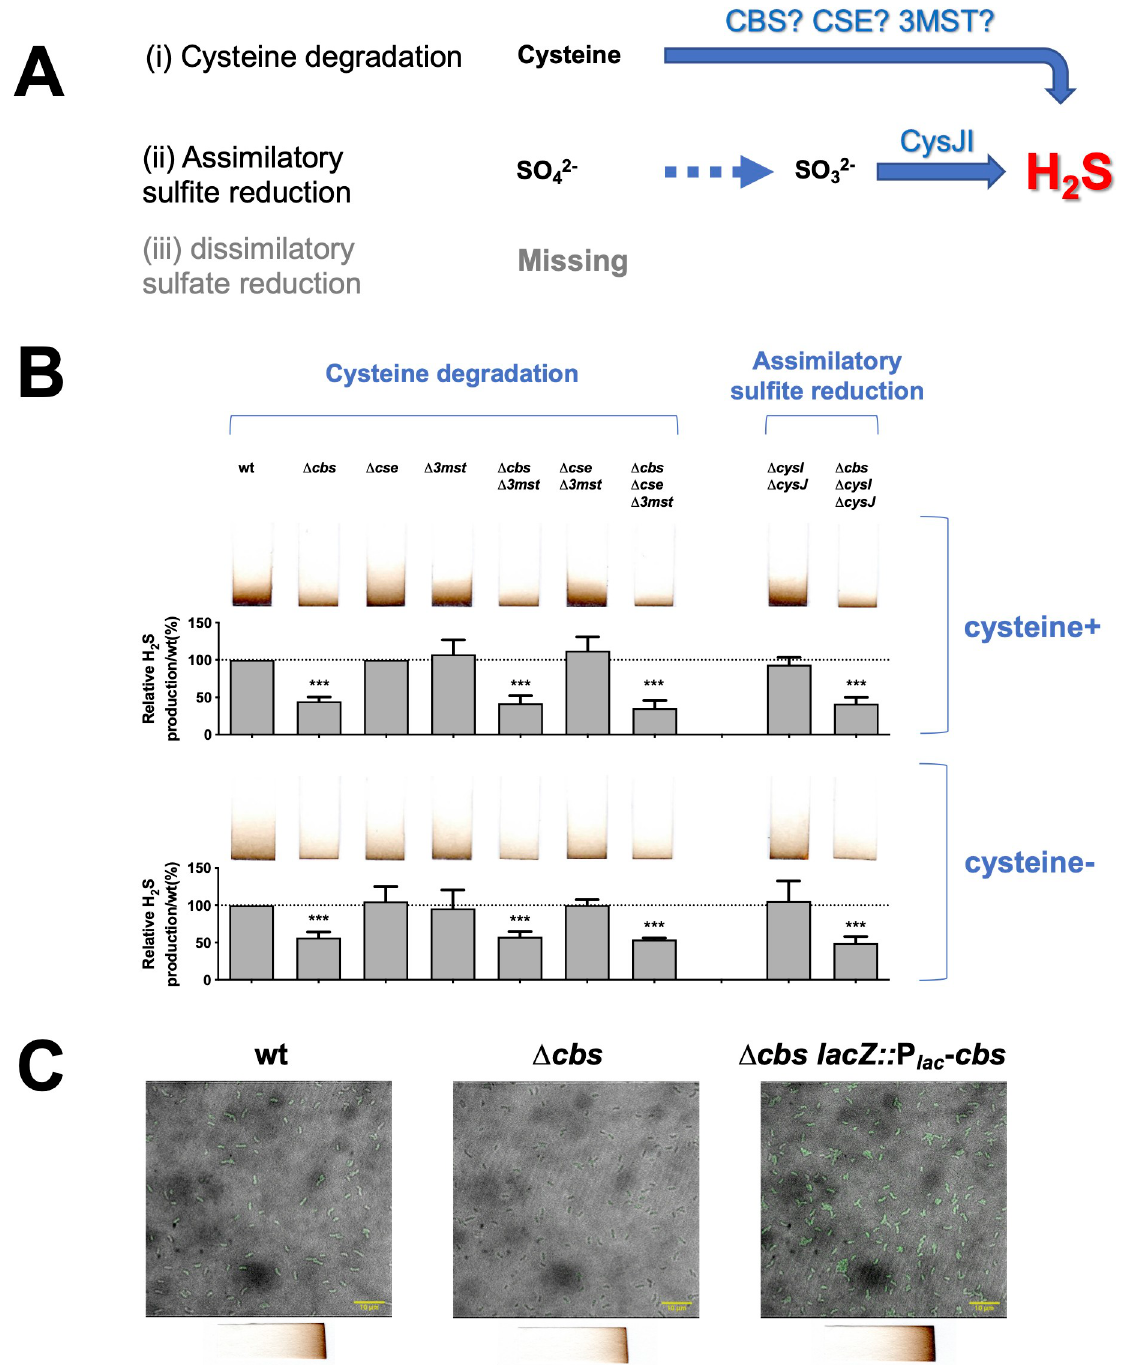
Fig 1. CBS is the key enzyme for H 2 S production in V . cholerae . (A). Schematic illustration of the proposed pathways for H 2 S biogenesis in V . cholerae . CBS, CSE and 3MST are key enzymes in cysteine degradation that are conserved from bacteria to mammals, while NADPH- dependent sulfite reductase (CysJI) catalyzes the last step in assimilatory sulfite reduction. (B). Cysteine degrading enzyme CBS is essential for H 2 S production. To investigate the contribution of cysteine degradation ( cbs , cse , and 3mst ) and assimilatory sulfite reduction ( cysI and cysJ ) to H 2 S synthesis in V . cholerae , H 2 S production was detected with Pb(Ac) 2 paper strips with (upper) or without (bottom) supplementation of 200 μ M L-cysteine hydrochloride in the culture medium. Stained paper strips were scanned and quantified with ImageJ. Average H 2 S level of the wild-type (WT) was set to 100% for subsequent normalization. Three replicates were sampled for each strain. Asterisks indicate statistically significant differences compared to WT as found by t -test ( ��� , p -value < 0.001). (C). Real-time